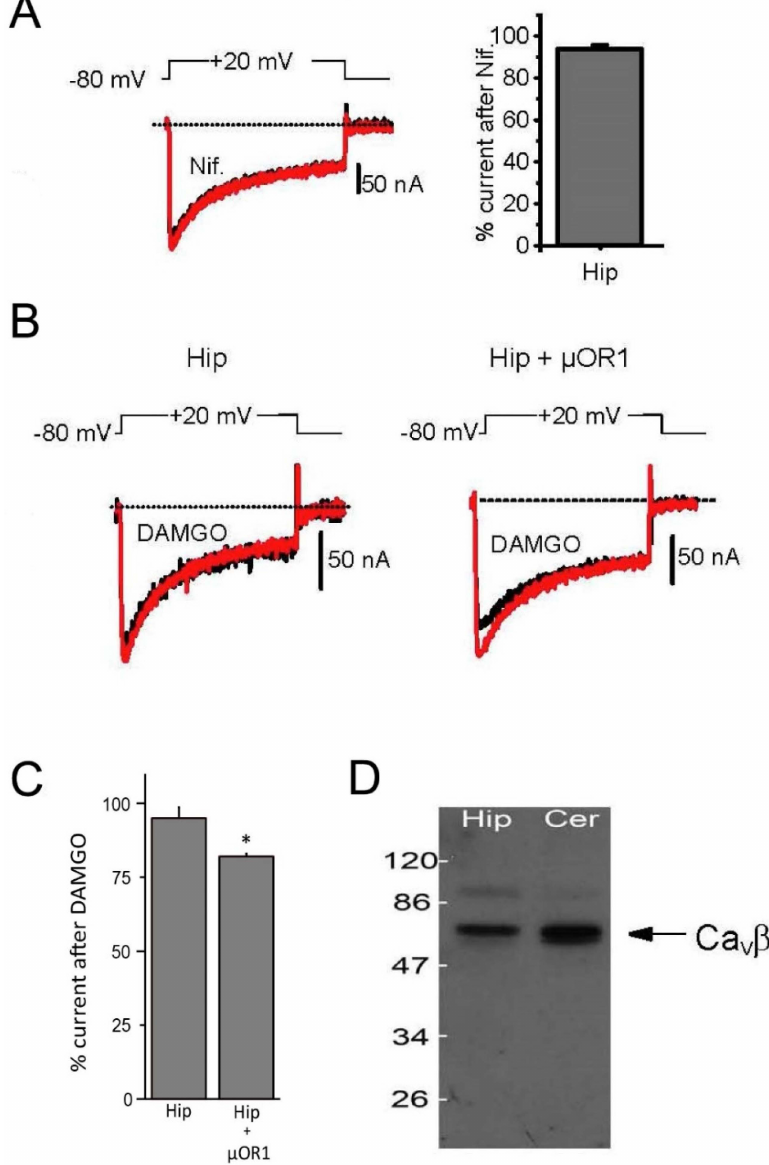
Figure 4. Pharmacology of the transplanted voltage-gated Ca 2+ channels. ( A ) Typical response of a hippocampal membrane-injected oocyte to 10 µ M nifedipine. Voltage-gated Ca 2+ currents were recorded during 400 ms-long depolarizations from − 80 mV to +20 mV in the presence of 40 mM Ba 2+ . Right: histogram showing the average response to nifedipine. ( B ) Response of transplanted voltage-gated Ca 2+ channels to the µ -opioid agonist DAMGO (10 µ M). Oocytes were injected with hippocampal membrane preparation, and were re-injected 24 h later with either H 2 O (Hip) or the µ 1 opiod receptor RNA at 1 ug/uL (Hip + µ OR1). Recordings were made 48 h after the hippocam- pal membrane injection. ( C ) Average response to 10 µ M DAMGO of transplanted voltage-gated Ca 2+ channels co-injected or not with the µ 1 opioid receptor RNA ( D ). Western blot using either hippocampal (Hip) or cerebellum (Cer) membrane preparations and probed with an anti-Ca V β com antibody showed that, in both cases, the cytoplasmic voltage-gated Ca channel auxiliary subunits, Ca V β , remained associated with the channel subunit(s). *—with injection. Channels encoded by the Ca V 2 family are tightly regulated by a G-protein-dependent regulation that is activated upon stimulation of the G-protein-coupled 7 transmembrane domain receptors [25]. In sensitive neurons, for example, the µ -opioid receptor µ OR has been shown to down-regulate Ca 2+ channel activity in a voltage-dependent manner